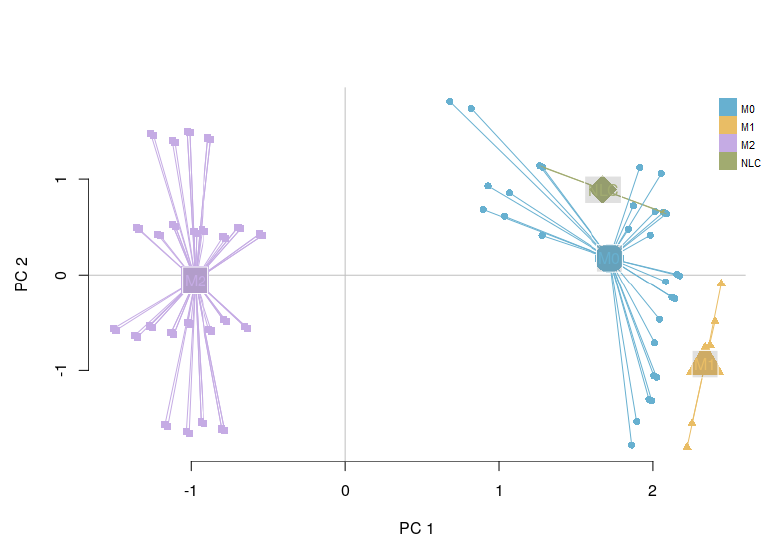
Figure 3. PCA of 214 attractors: M1 and M2 attractors are observed in distinct clusters, while NLC attractors appear in between the two extremes of the polarization spectrum.